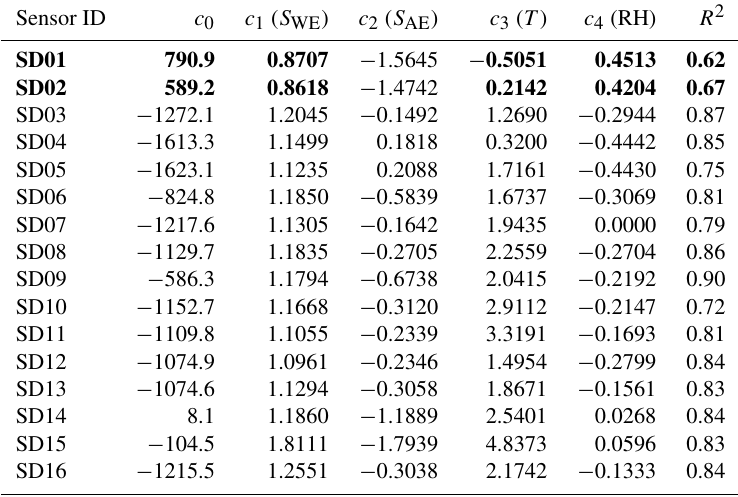
Table 3. Fit results for regression model D. Older NO2-B42F sensors highlighted in